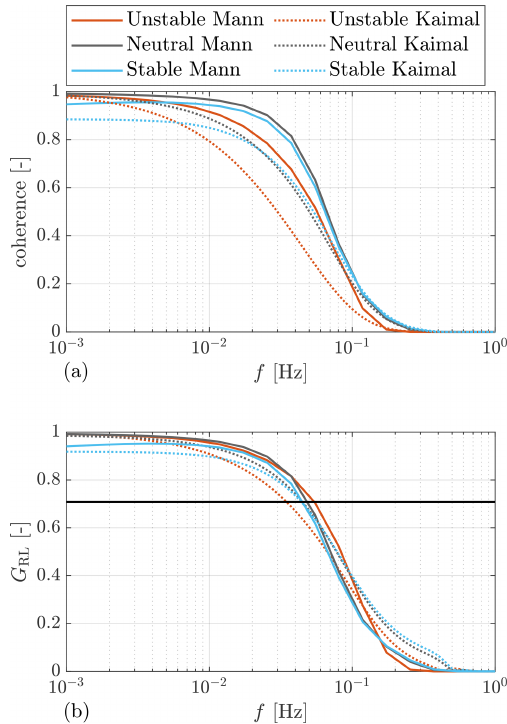
Figure 4. (a) Coherence between lidar-estimated REWS and the turbine based REWS. (b) The optimal transfer function gain. The black dot line corresponds to the − 3dB magnitude. The results are calculated with a mean wind speed of 16ms − 1